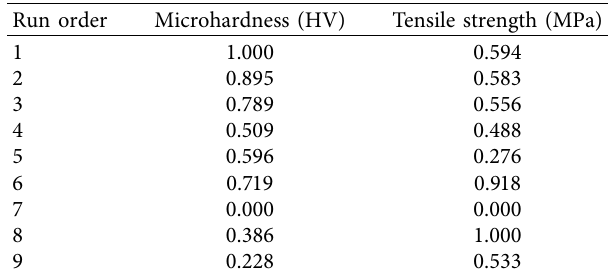
Table 8: Normalized values for the output response.